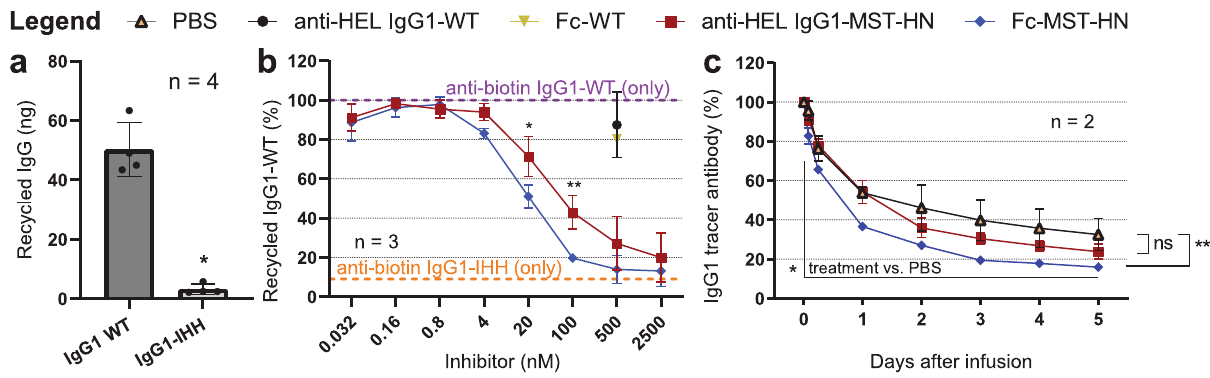
Fig.5|Fc-MST-HNinhibitsFcRn-mediatedrecyclingofIgGinvitroandreduces IgG tracer levels in cynomolgus monkeys more ef fi ciently than IgG1-MST-HN. a Absolute amounts of recycled anti-biotin IgG1-WT and anti-biotin IgG1-IHH in experimentsusingHEK-FcRn-GFPcellsasmeasuredbyELISA. b Relativeamountof recycled anti-biotin IgG1-WT. Cells were preloaded with the inhibitors at different concentrations, washed extensively, and then loaded with a fi xed concentration of anti-biotin IgG1-WT, again washed extensively, and incubated under culture con- ditions.Recycledamountsofanti-biotinIgG1-WTwerequanti fi edbyELISAthenext day. Data represent aggregated data presented as mean values from four inde- pendent experiments in ( a ) and three in ( b ).Data in ( b ) are normalizedto medium control (in two experiments) or point of least inhibition. Error bars indicate stan- dard deviations. c Cynomolgus monkeys were assigned to groups of two animals per group and injected with 1mg/kg anti-mouse CD70-hIgG1 tracer antibody5min